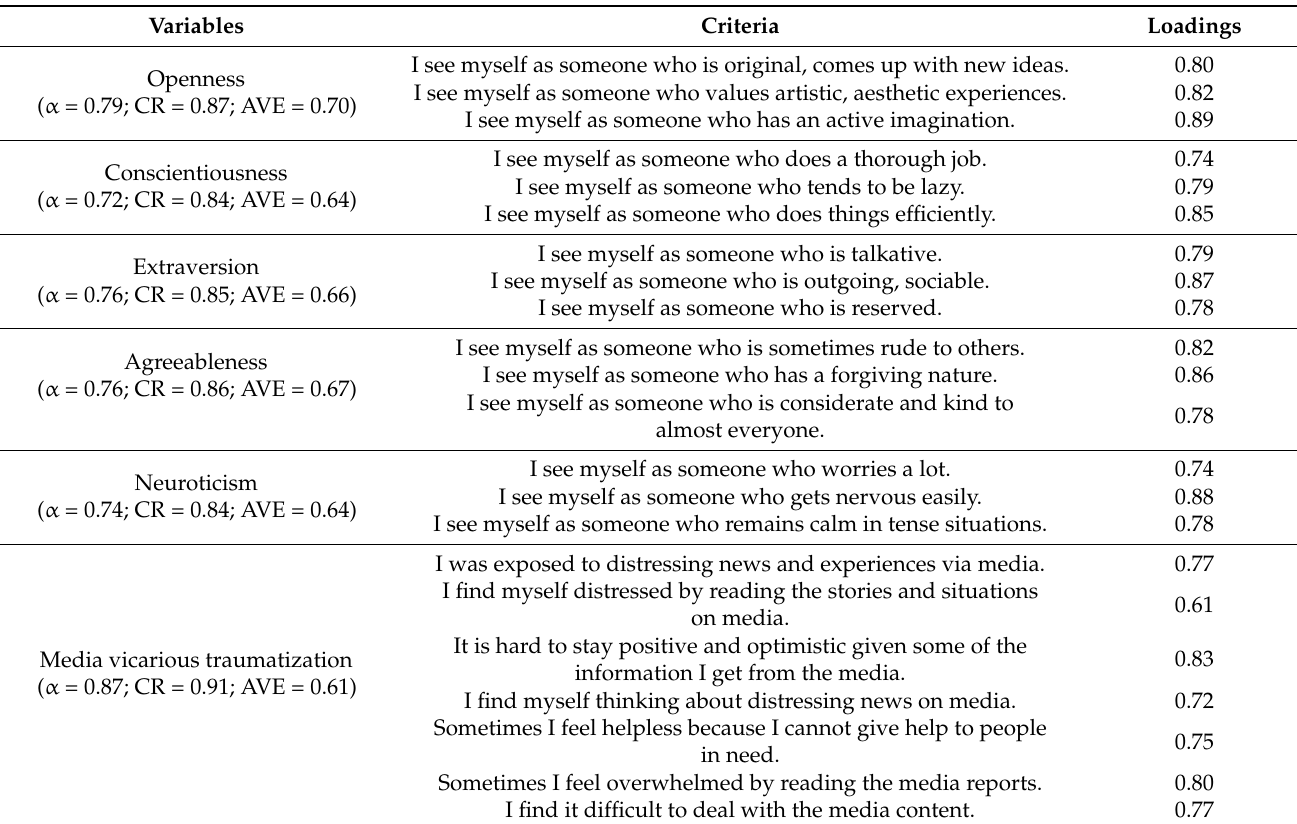
Table 2. Reliability and convergent validity (the Big Five Inventory-Short Version and Media Vicarious Traumatization Scale).